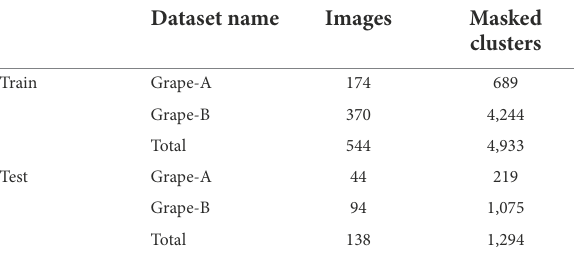
TABLE 2 Training set and test set